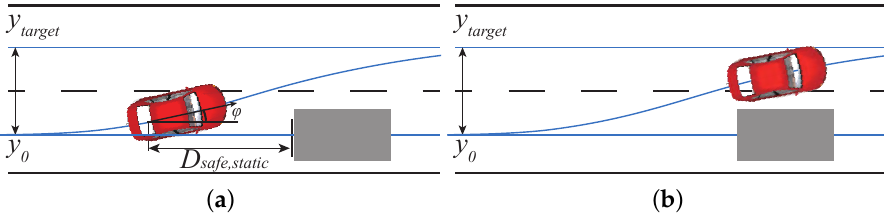
Figure 4. The safe distance of evasive maneuver for static obstacle. ( a ) The extreme trajectory of evasive maneuver using evasive motion model. ( b ) The critical position of evasive